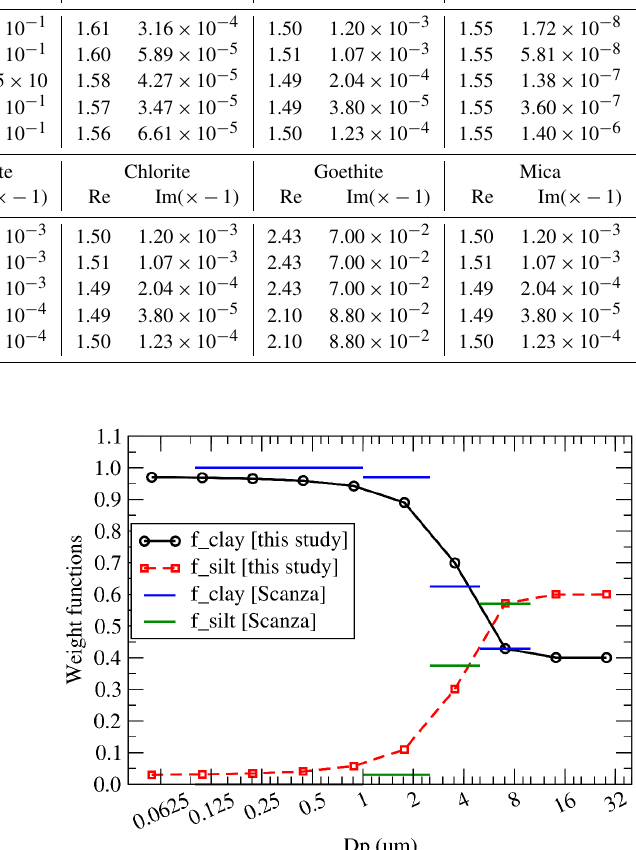
Table 2. Values of refractive indices (Real, Re, and Imaginary, Im, parts) selected for the 12 mineralogical species and for the five tabulated wavelengths, λ , required by the FastJX optical properties model. Smectite Illite Hematite Feldspar